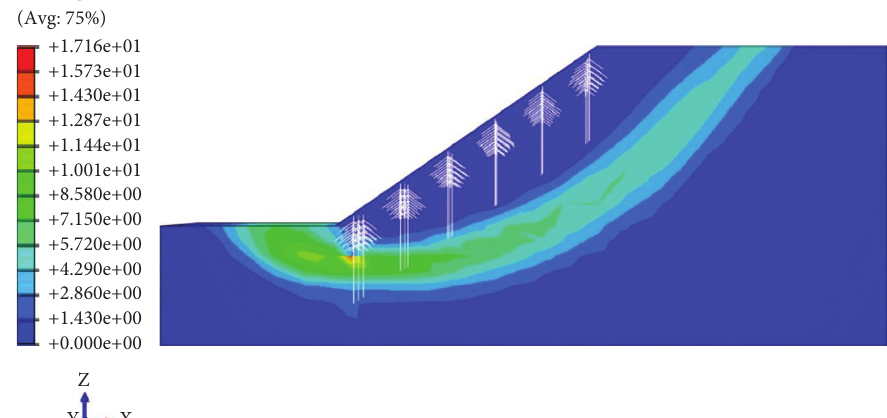
Figure 9: Cloud map of the distribution of the plastic strain area of the slope.